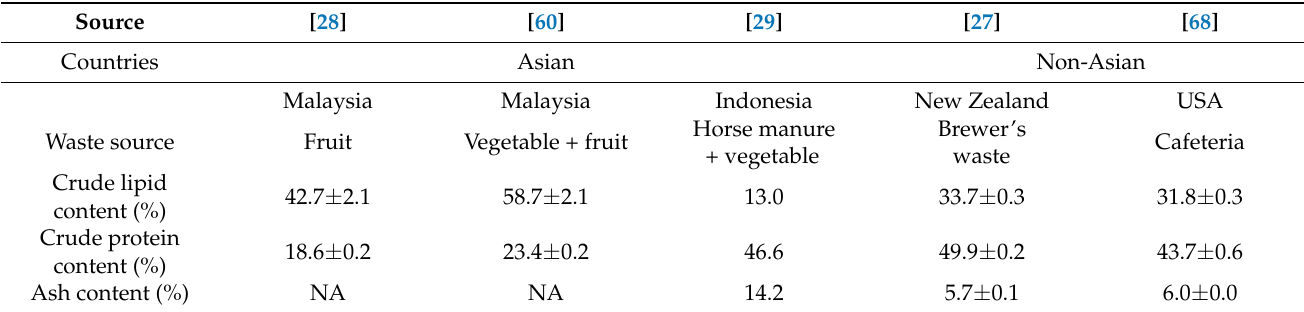
Table 3. Summary on the chemical composition of BSFL fed with food waste. NA: Not available.